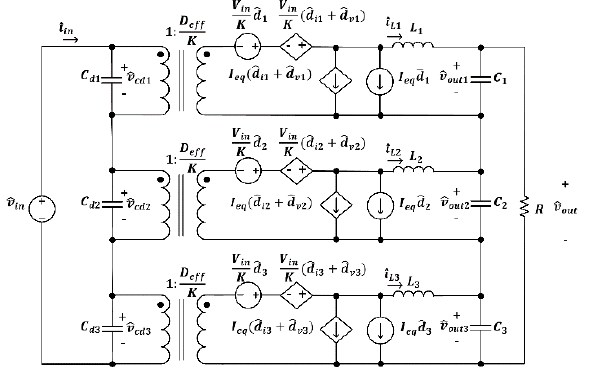
Figure 2. ISOS DC-DC converter small-signal modeling (SSM).